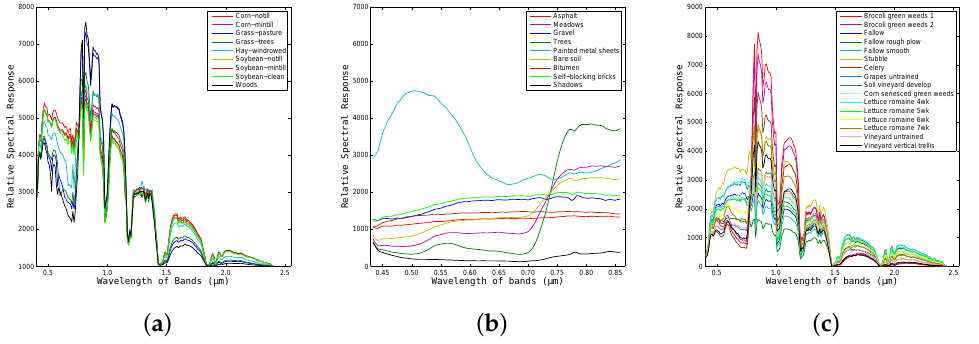
Figure 11. Average spectral signature of each class for all labeled pixels in the ground-truth data for the ( a ) Indian Pines, ( b ) University of Pavia, and ( c ) Salinas Valley